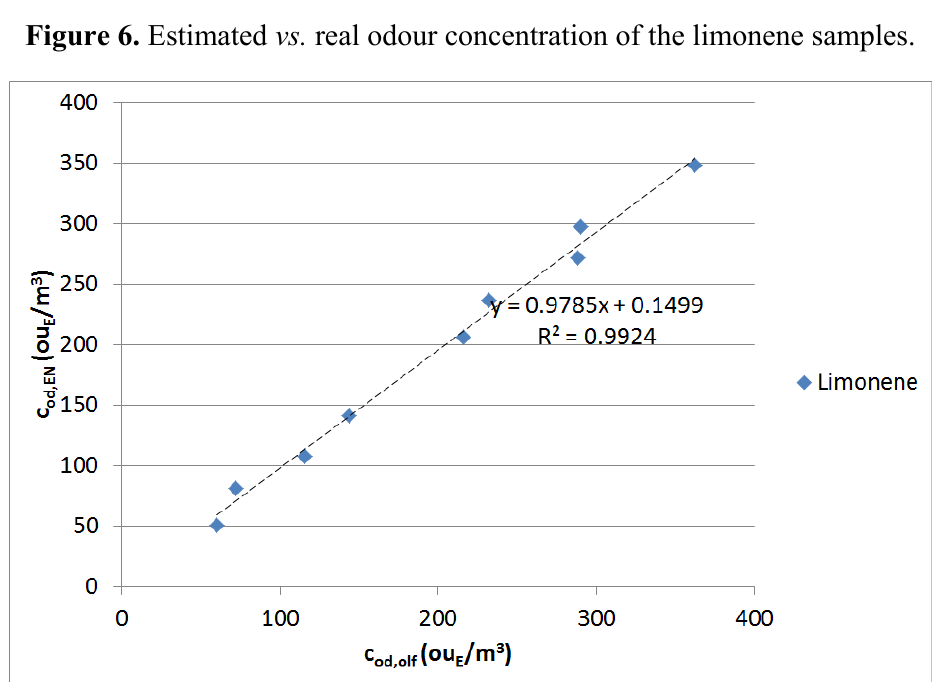
) vs. measured by od,EN